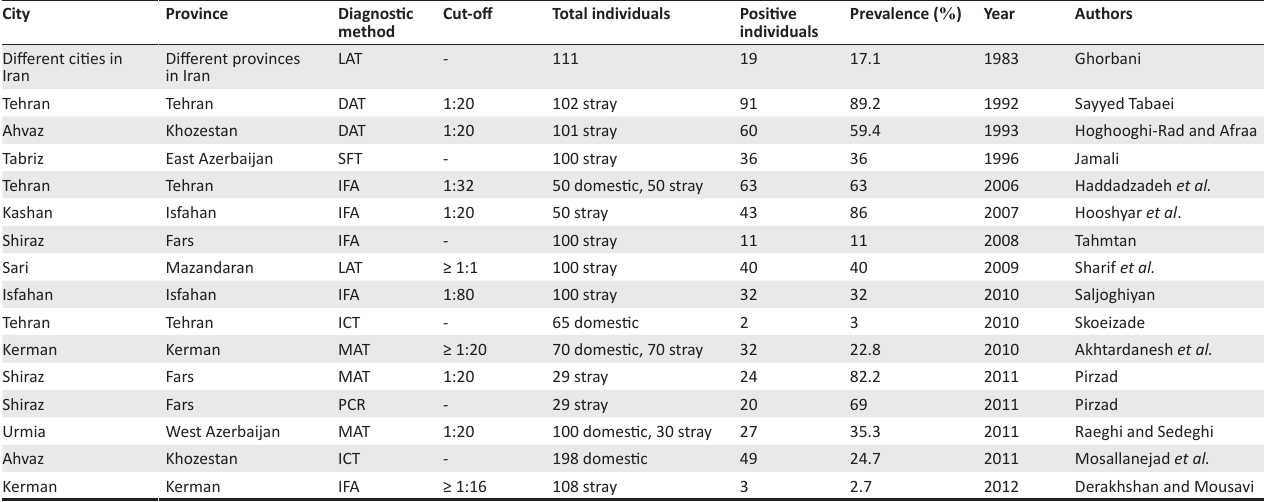
TABLE 1: Publications on cat toxoplasmosis included for meta-analysis.